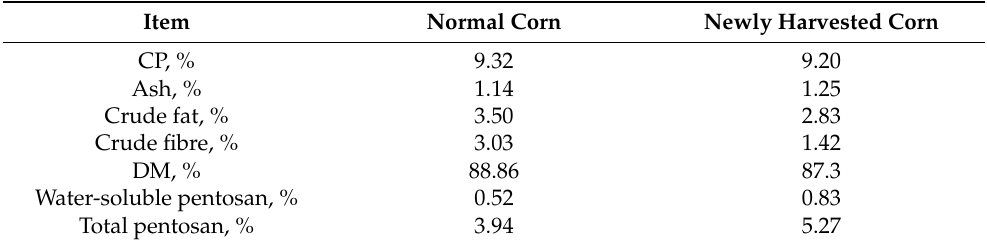
Table 2. Chemical composition analysis of normal corn and newly harvested corn.